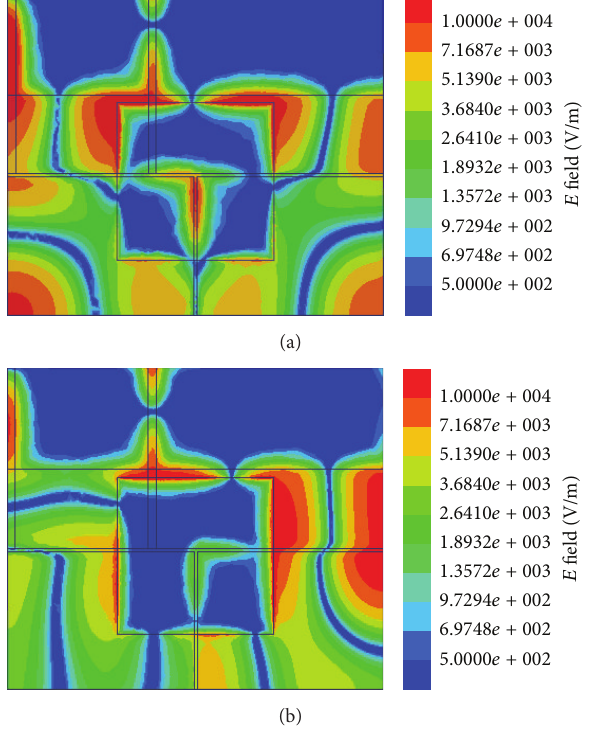
Figure 5: Simulated electric field distributions on the ground plane of the proposed antenna: (a) 5.18 GHz and (b) 5.4